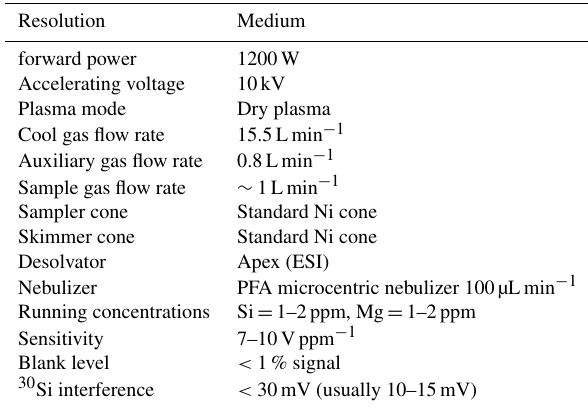
Table 2. Mass spectrometer operating